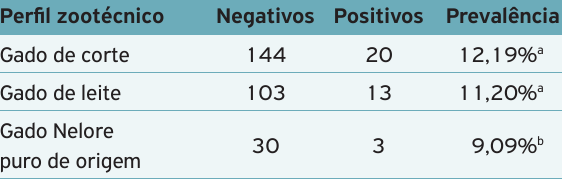
Tabela 1. Distribuição da prevalência de leucose enzoótica bovina entre os perfis zootécnicos de animais da região médio- norte mato-grossense, Brasil,